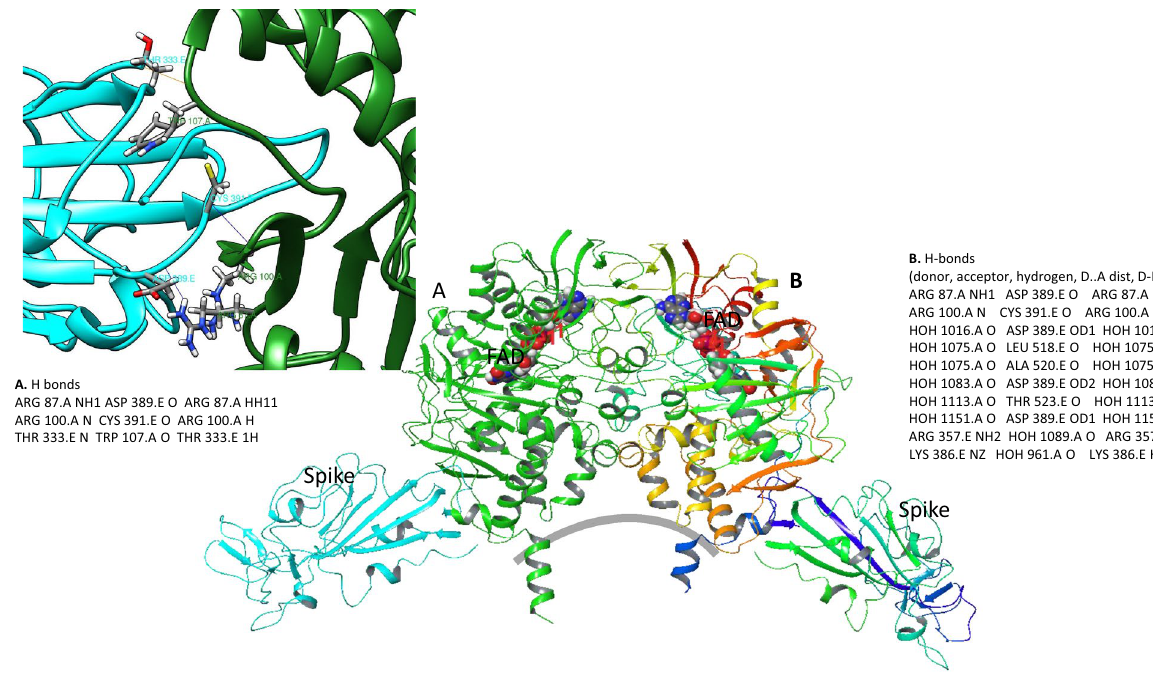
Figure 7. Computational Protein–Protein docking analysis of the energetically preferred binding location for Spike proteins to MAOB (Schrodinger Inc.). Approximate location of the bilayer is indicated with a gray line. Binding energy calculation was performed for 70,000 consecutively selected positions of Spike protein as ligand and each chain of MAOB as a receptor. Shown are Spike proteins, MAOB chains as well as FAD—flavin adenine dinucleotide cofactor. Figure and analysis is done using Schrodinger 2020–2 (Schrodinger Inc.) 35